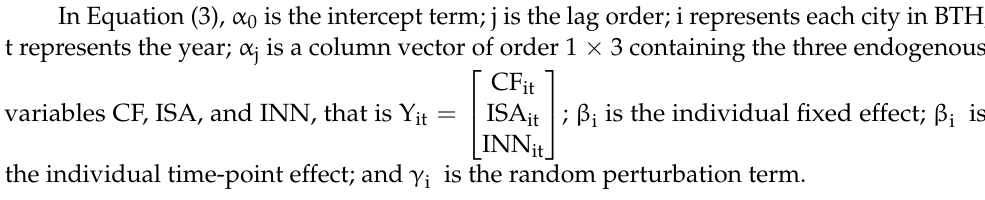
Table source: authors’ own